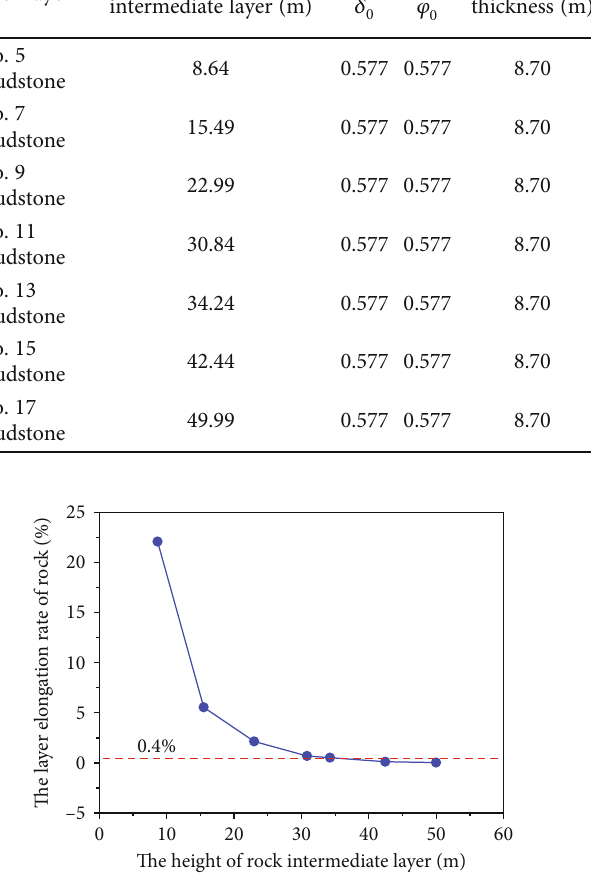
Figure 7: Relationship curve between the layer elongation rate of rock and the height of rock intermediate